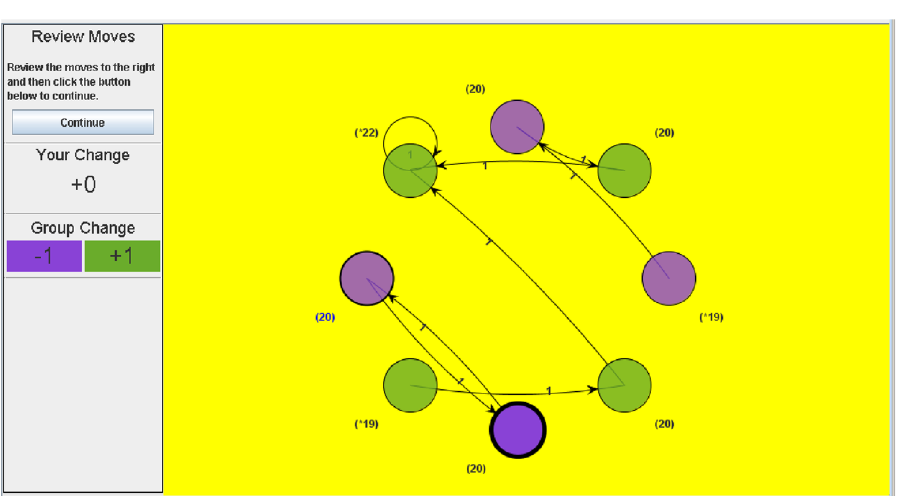
Figure 2. VIAPPL screen presented to players at the end of a round, displaying all token allocations from that